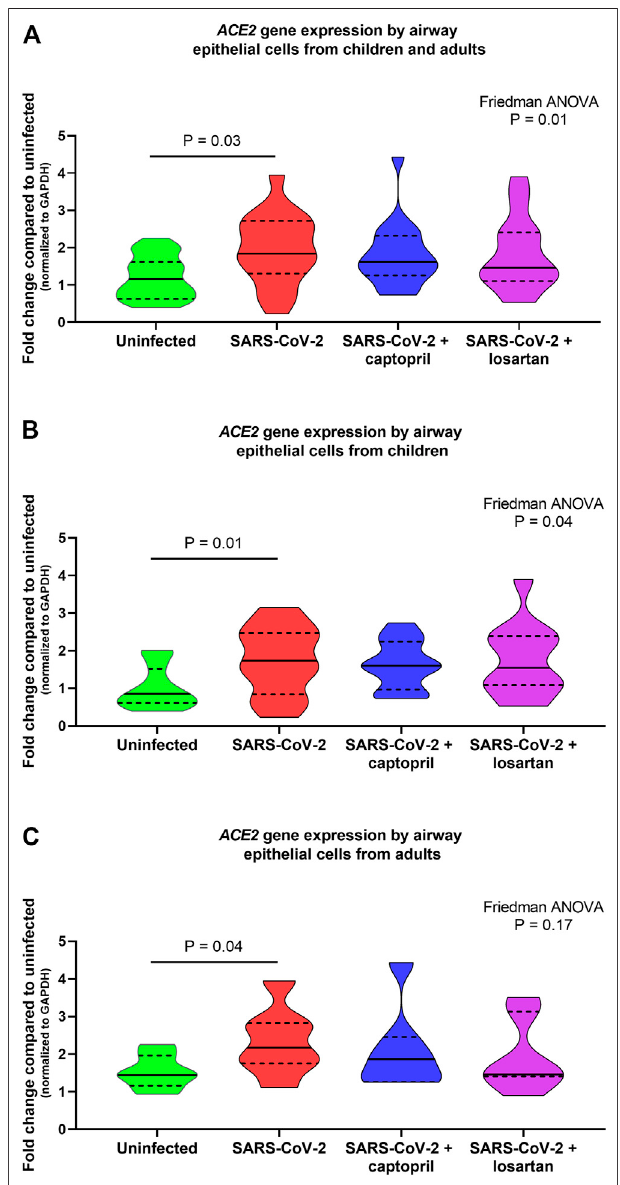
FIGURE 2 | Relative gene expression of ACE2 (normalized to GAPDH expression) by organotypic bronchial airway epithelial cell cultures from